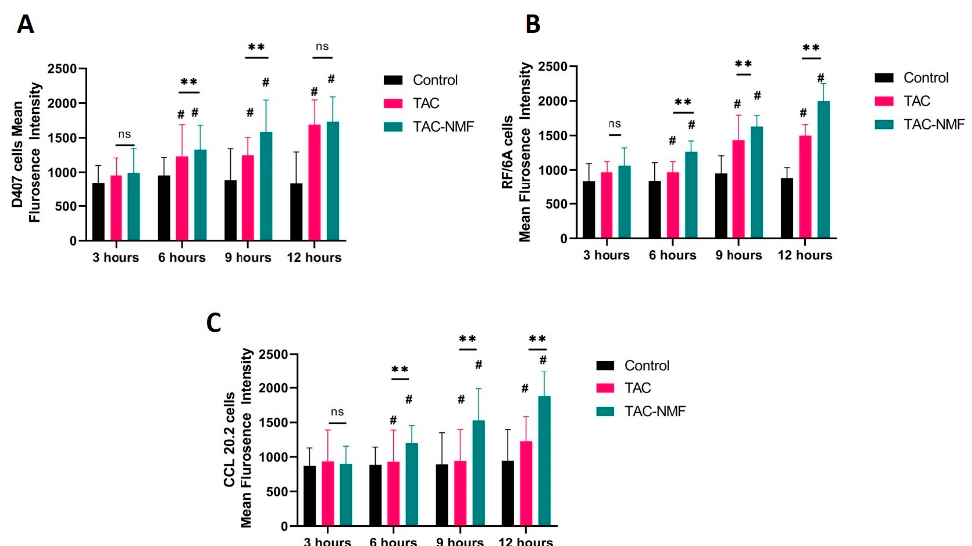
Figure 10. Time dependent uptake and quantification of FITC-labelled TAC solution and FITC-labelled TAC-NMF solution in ( A ) D407, ( B ) RF / 6A and ( C ) CCL 20.2 cells using fluorescence assisted cell sorting (FACS). Results are expressed as a mean of three independent experiments, n = 3 ± SD. (# ≤ 0.05 as compared to control and ** p ≤ 0.01 between group, ns = not significant difference between